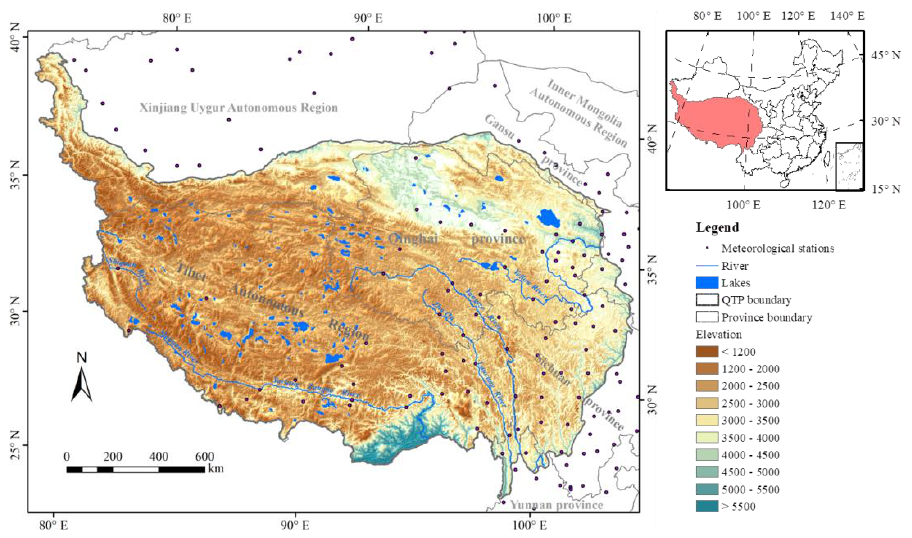
Figure 1. Geographical location and topographic map of the Qinghai-Tibet Plateau.